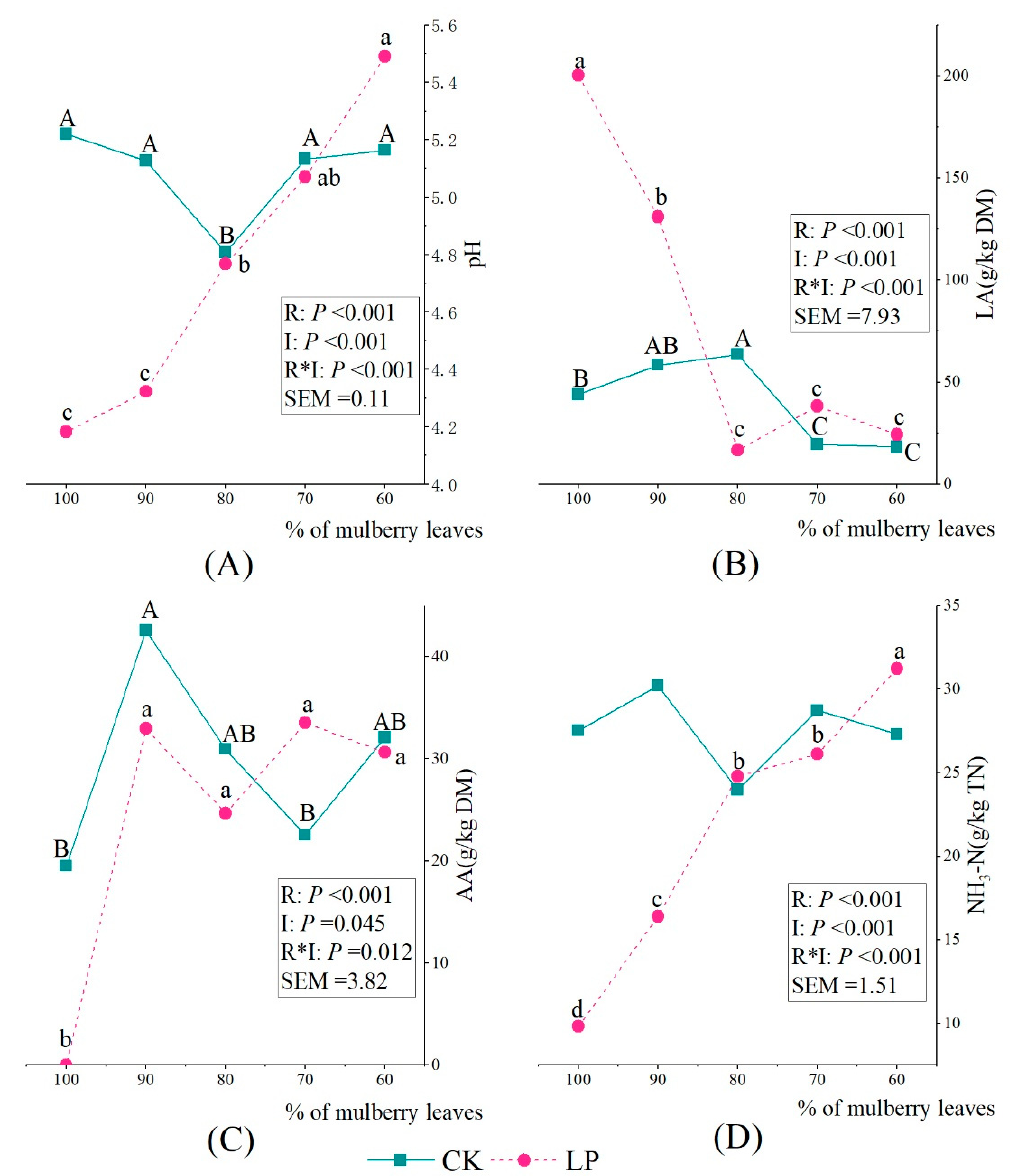
Figure 1. The pH value ( A ), LA ( B ), AA ( C ), and NH 3 -N ( D ) concentration in the non-inoculated and inoculated mixed silage with different mulberry leaf proportions. CK, silage without inoculation; LP, silage inoculated with L. plantarum A345. Means with different capital letters represent significant difference among different mixed ratios in the non-inoculated silage at p < 0.05. Means with different small letters represent significant difference among different mixed ratios in the inoculated silage at p < 0.05. R, ratio of mulberry leaves and smooth bromegrass; I, inoculation. SEM, standard error of means The text continues here (Figure 2 and Table 2).